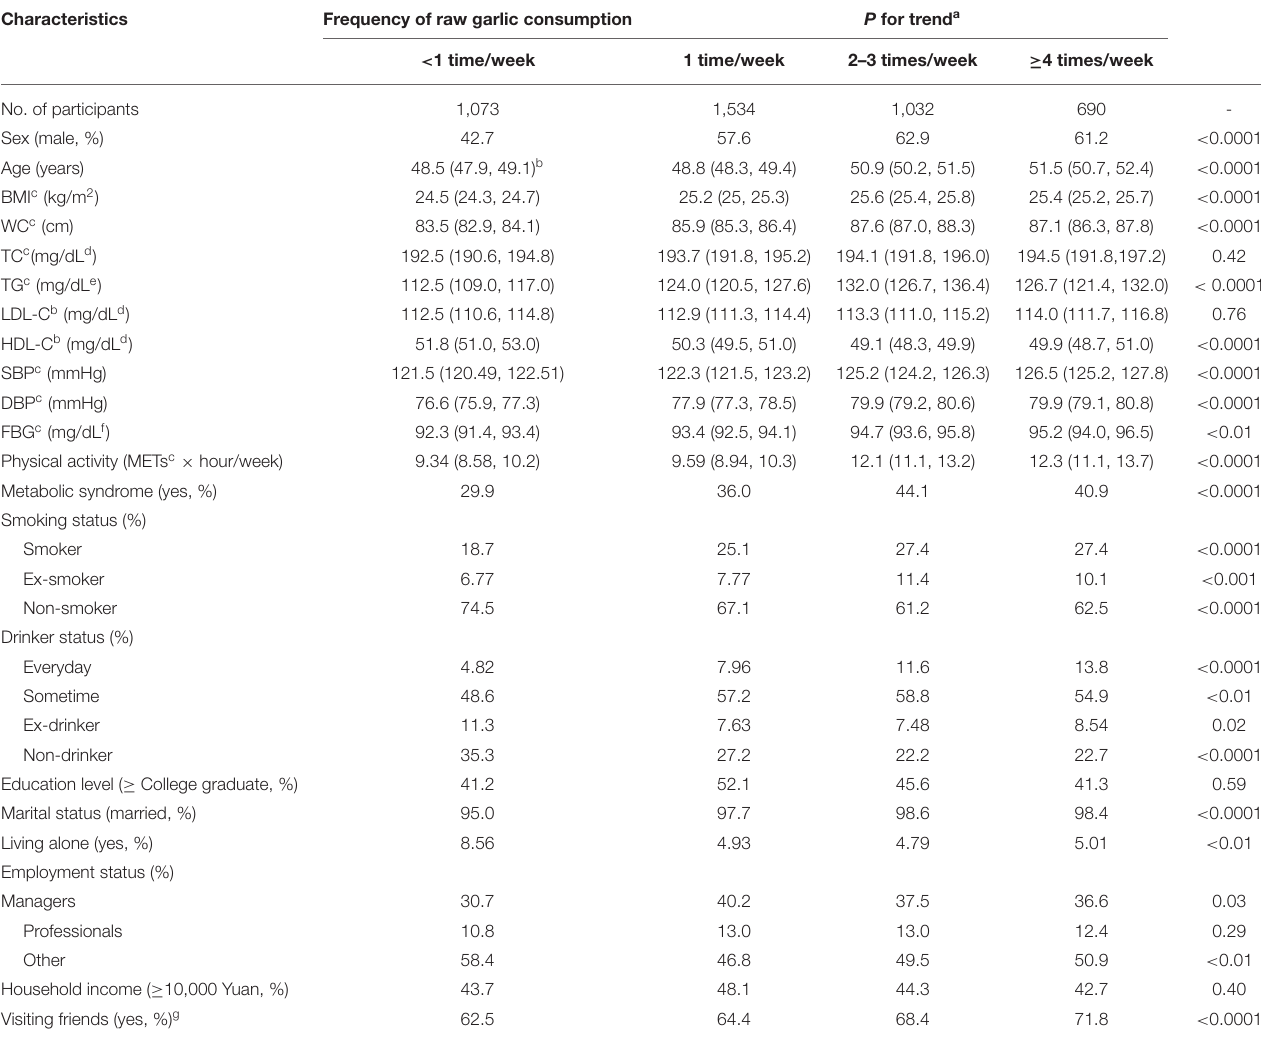
TABLE 1 | General characteristics of 4,329 Chinese adults according to the frequency of garlic consumption, the Tianjin Chronic Low-grade Systemic Inflammation and Health Cohort Study 2015–2017.